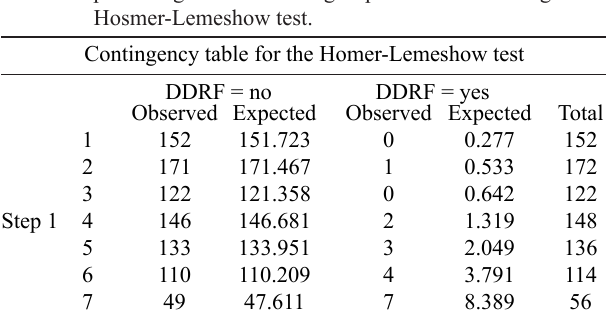
Table 5. DDRF observed and predicted using EuroSCORE as predicting variable in the groups defined according to the Hosmer-Lemeshow